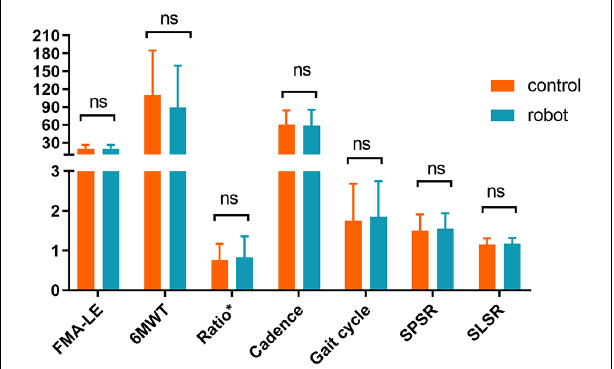
FIGURE 4 | Baseline assessment of the subjects. *Ratio: single stance time vs. swing phase on the affected side. SPSR, swing phase symmetry ratio; SLSR, step length symmetry ratio. Error bar indicates the SD. ns: not